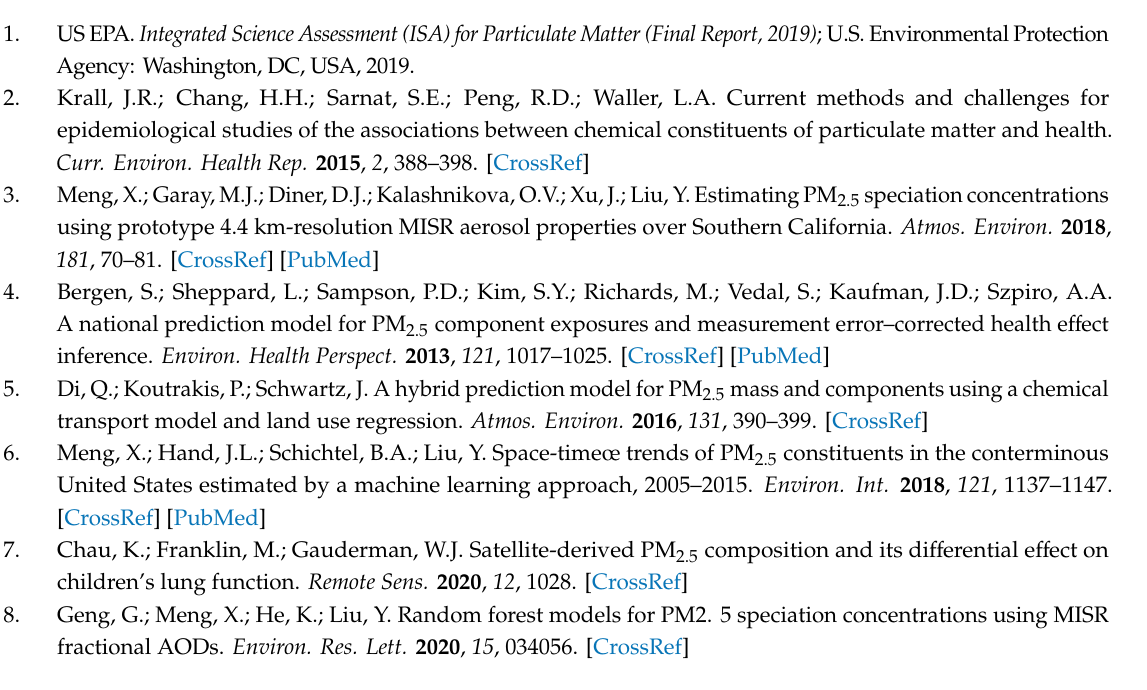
Table S1. Particle properties of the eight MISR fractional AOD; Table S2. Results comparison with alternative BART models; Table S3. Results comparison with the primary BART model without tuning; Figure S1. Locations of PM2.5 component monitors; Figure S2. Locations of monitoring data and test group; Figure S3. BART variable importance (proportion in trees); Figure S4. BART variable importance (proportion in trees) for all variables; Figure S5. Marginal e ff ects of the most important fractional AOD parameter and CMAQ